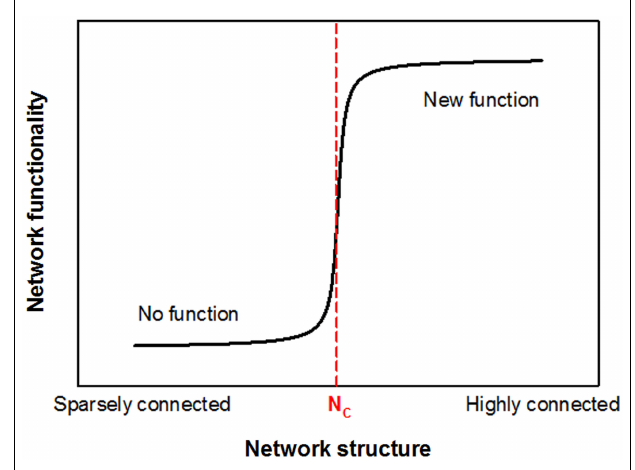
FIGURE 2 |A conceptual representation of network associated phase transitions. The horizontal axis represents some measure of network structure that can range from “sparsely connected” to “highly connected” configuration. In percolation, this would represent the probability p that a bond is occupied.The vertical axis is related to some functional property of the network. For example, in percolation it can represent the fraction of networks in an ensemble that percolate the system or the probability that a bond belongs to the percolating cluster. If flow such as fluid or electrical current that can be carried by the network is of interest as a functional property, there would be essentially no function available for the network below a critical organization of its structure N C that corresponds to p c in percolation. It can be seen that the functionality of the network suddenly changes, once its structural organization reaches the critical configuration at N C which represents a phase